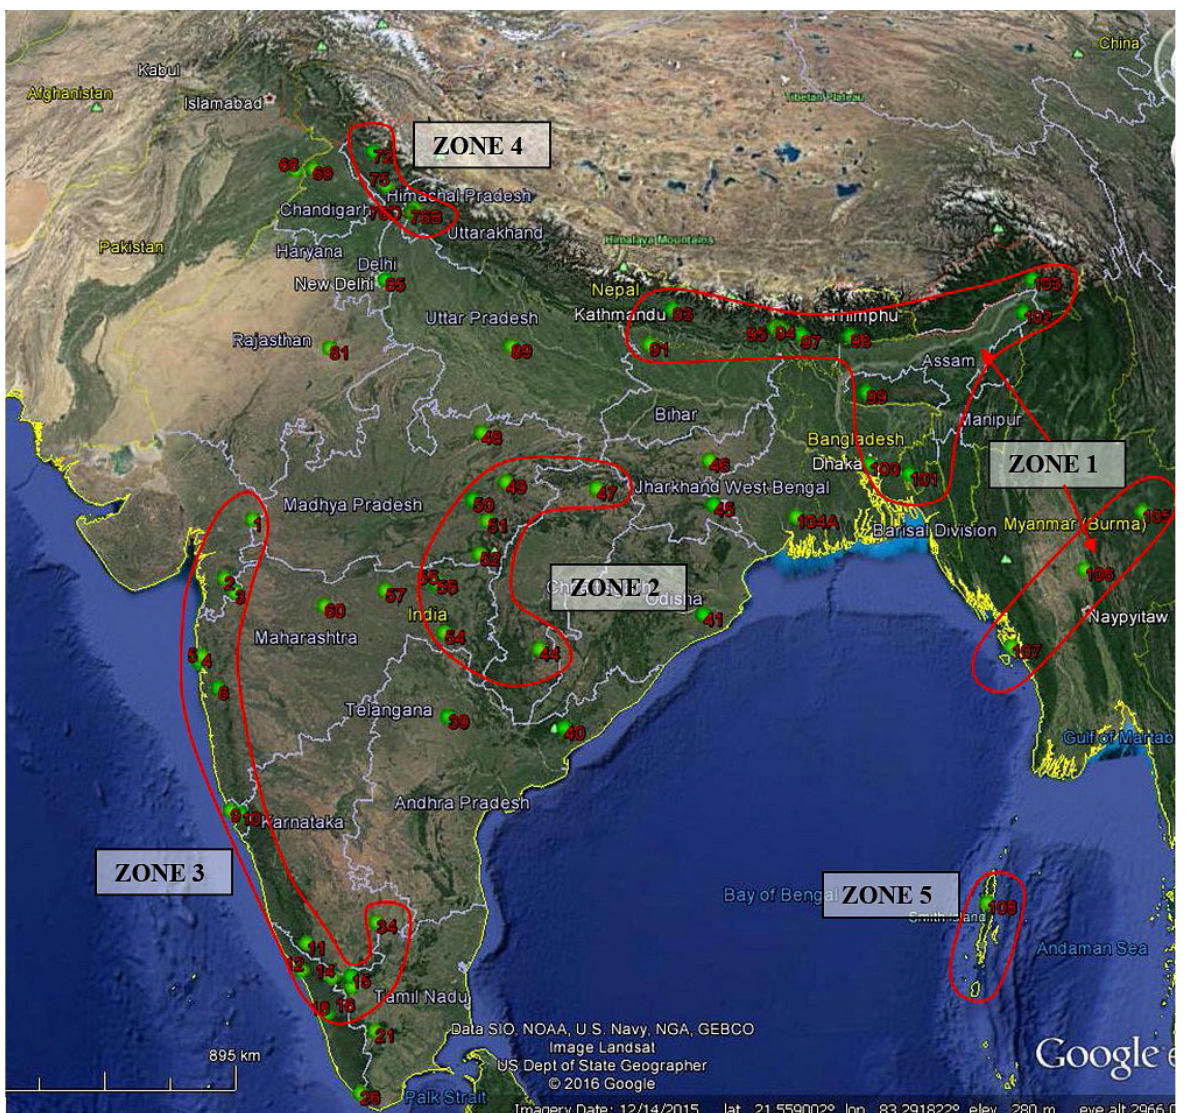
Figure 2a. Records of presence of Euthalia